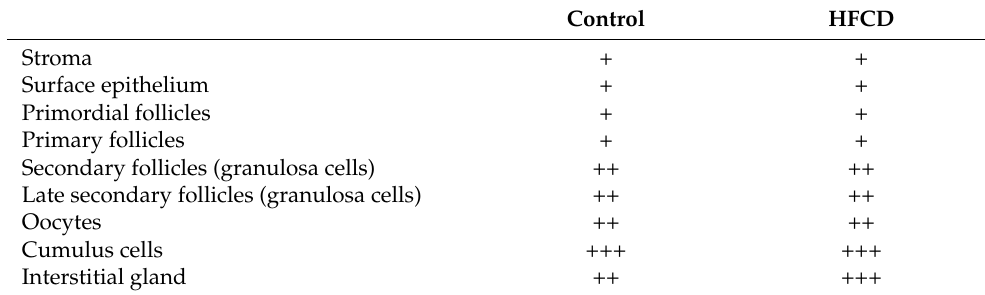
Figure 1. Representative photo stitching of Masson’s trichrome staining ovary sections and follicular counting of rabbits fed either a control diet or HFCD. ( a , e ) Ovarian histology. ( b – d , f – h ) Amplification showing primordial (P), Transition (T), Primary (Pr), Preantral (Pa), Early antral (Ea), Late antral (La), atretic follicle remnants (black arrow) and Atretic follicles (At), corpus luteum (CL), and Interstitial gland (IG). Scale: ( a , e ): 500 µ m. ( b – d , f – h ): 100 µ m. ( i ) Histogram of the mean number of follicles depending on the type of rabbit ovarian follicle, fed either a control diet or HFCD. Each box represents the mean value ± ESM for each group. Statistical significance was set at * p < 0.05. Table 4. Qualitative determination of lipofuscin stained SBB in different cell types in ovaries of both the control and